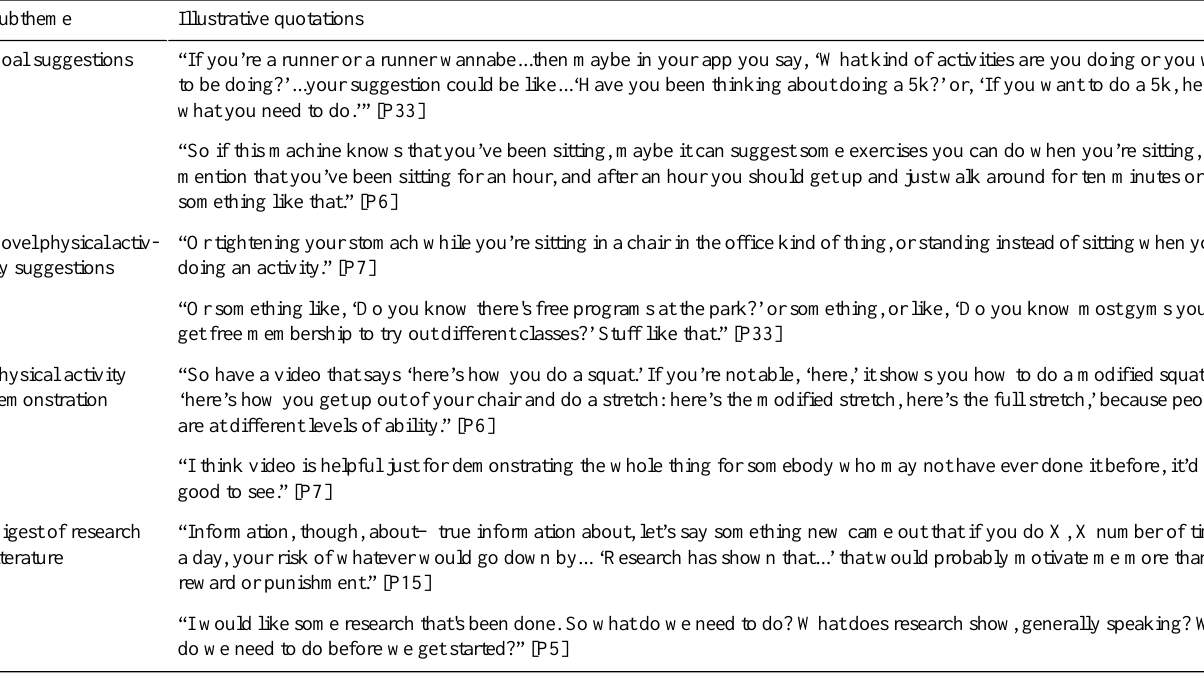
Table 4. Prescription for physical